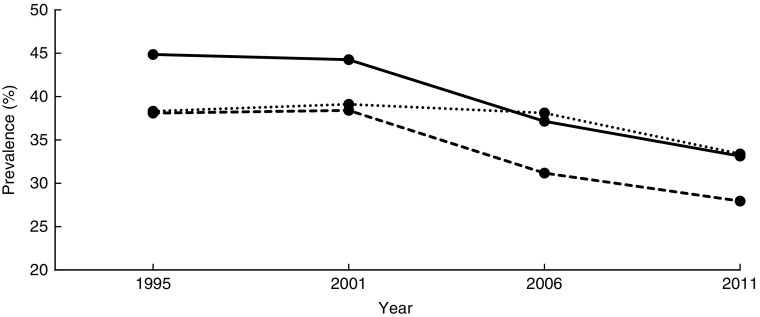
Overall stunting trends among children aged <5 years according to standard (, National Center for Health Statistics/Centers for Disease Control and Prevention International Reference Population(

24

); , WHO Child Growth Standards(

23

); , Uganda Demographic and Health Survey published data): Uganda Demographic and Health Survey 1995, 2001, 2006 and 2011(

4

,

13

,

19

,

20

)